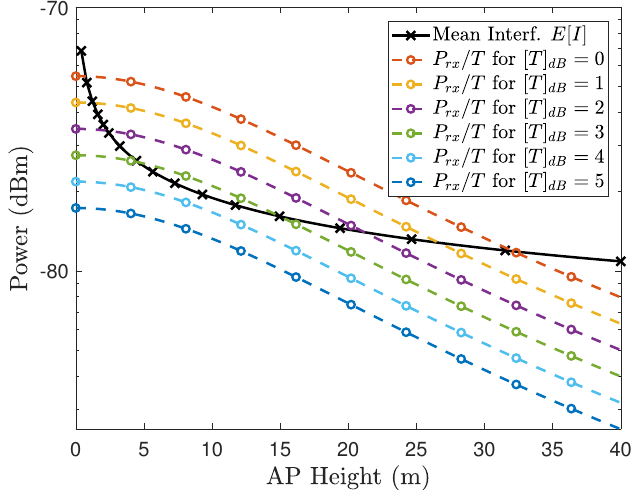
Figure 4. Received power and mean aggregated interference power vs. AP height h , for a target UE located at R 0 = 20 m equipped with a uniform circular array (UCA) with N c = 128 that has average power gain ¯ G 2 c = 0.012. Parameters: SIR threshold [ T ] dB = { 0,1, 2,3,4, 5 } , interferer density λ = 5 × 10 − 3 m − 2 , path-loss exponent 2 b = 2.4, central frequency F c = 28 GHz, and transmit